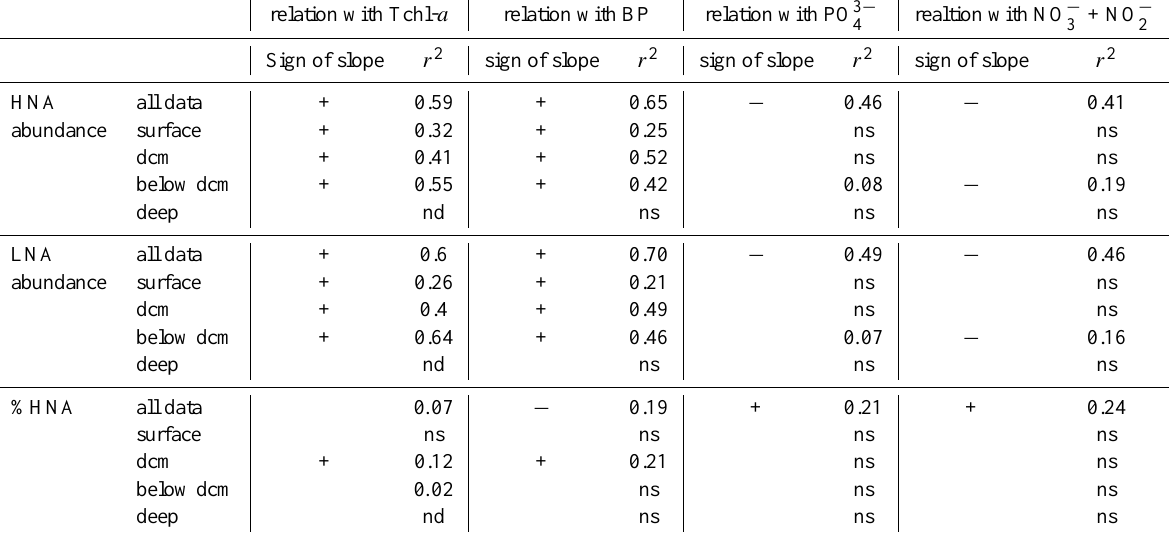
Table 2. Relationships between abundance of HNA cells, abundance of LNA cells and %HNA versus TChl- a , versus BP, versus